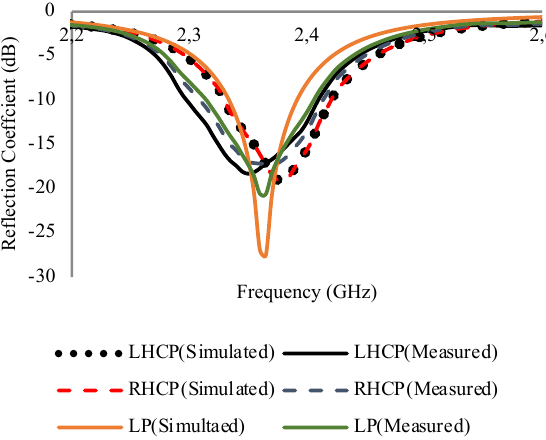
Figure 5(b): Simulated and measured reflection coefficient (dB)